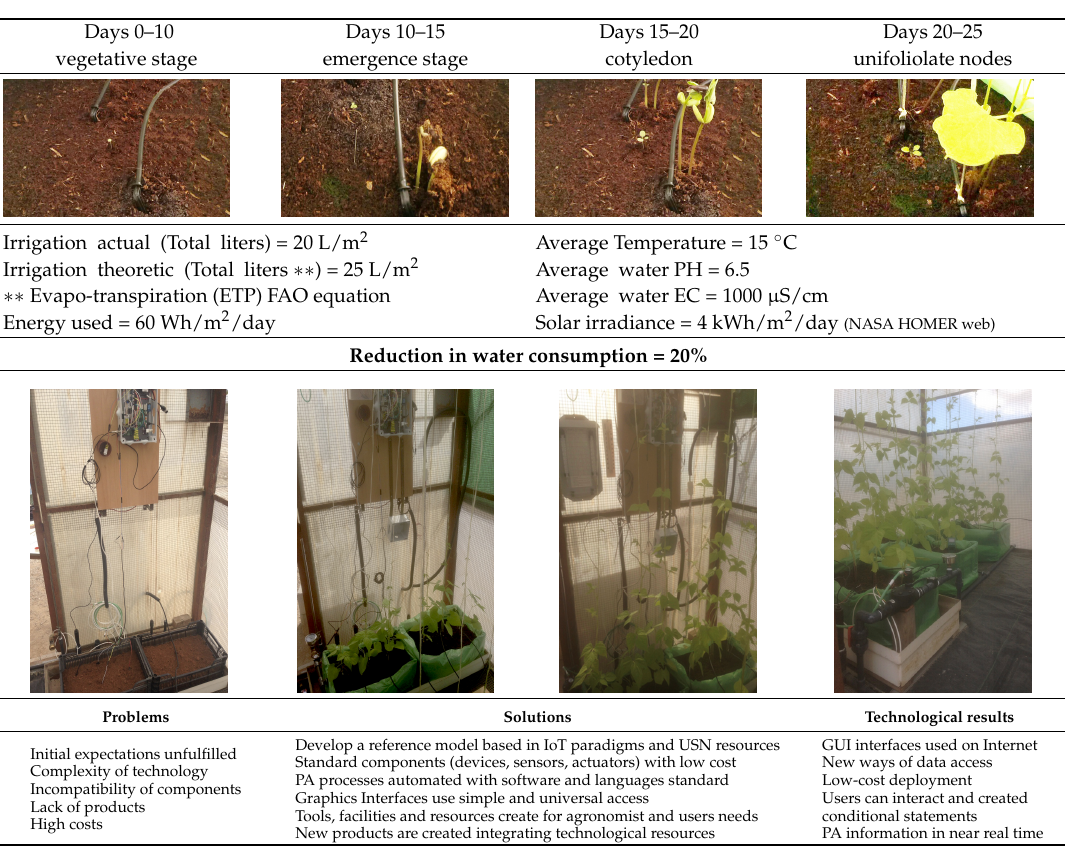
Table 5. Growth crop process on experimental station. Beans Growth